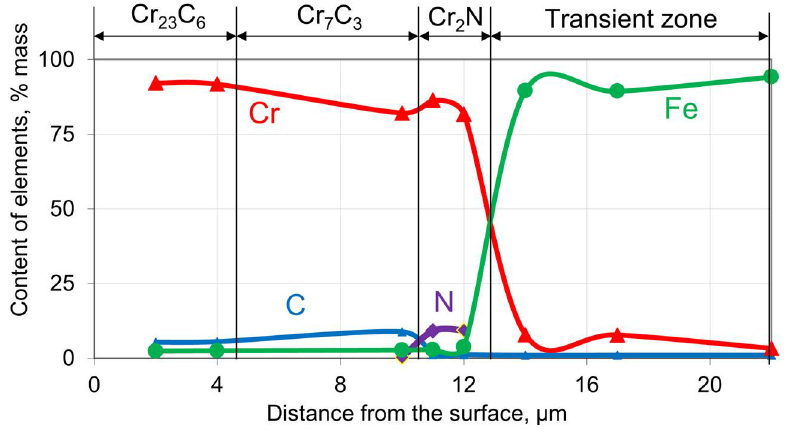
Figure 6. Distribution of chemical elements for steel DIN 105WCr6 after nitrogenchroming: nitriding